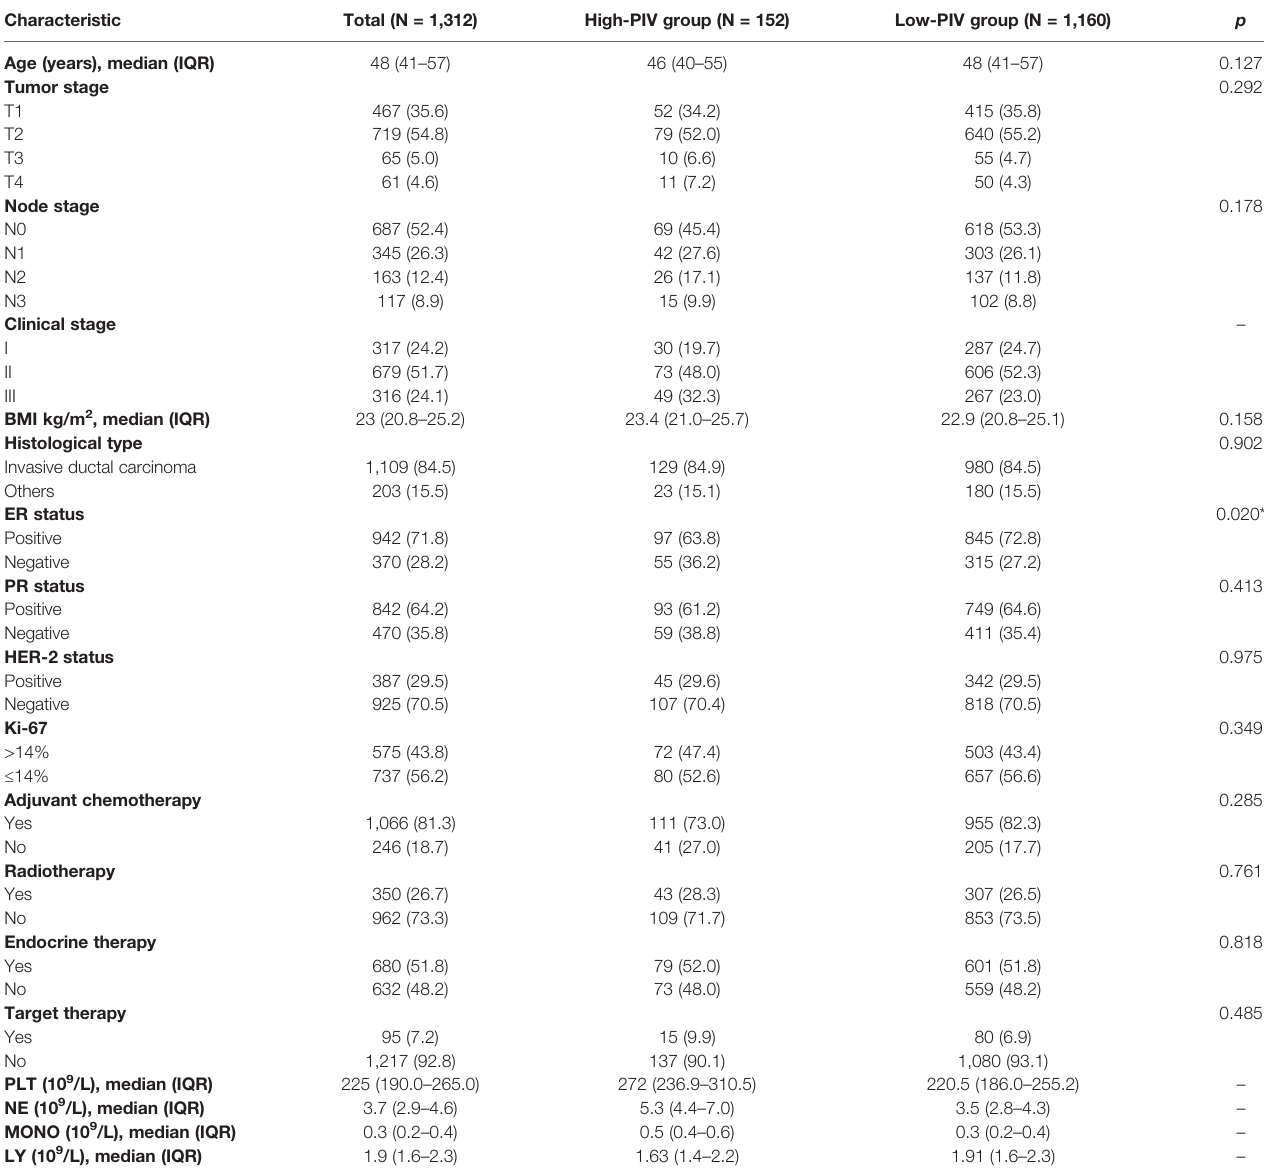
TABLE 1 | The relationship between PIV and clinicopathological characteristics in the whole cohort. Characteristic Total (N = 1,312) High-PIV group (N = 152) Low-PIV group (N = 1,160) Age (years), median